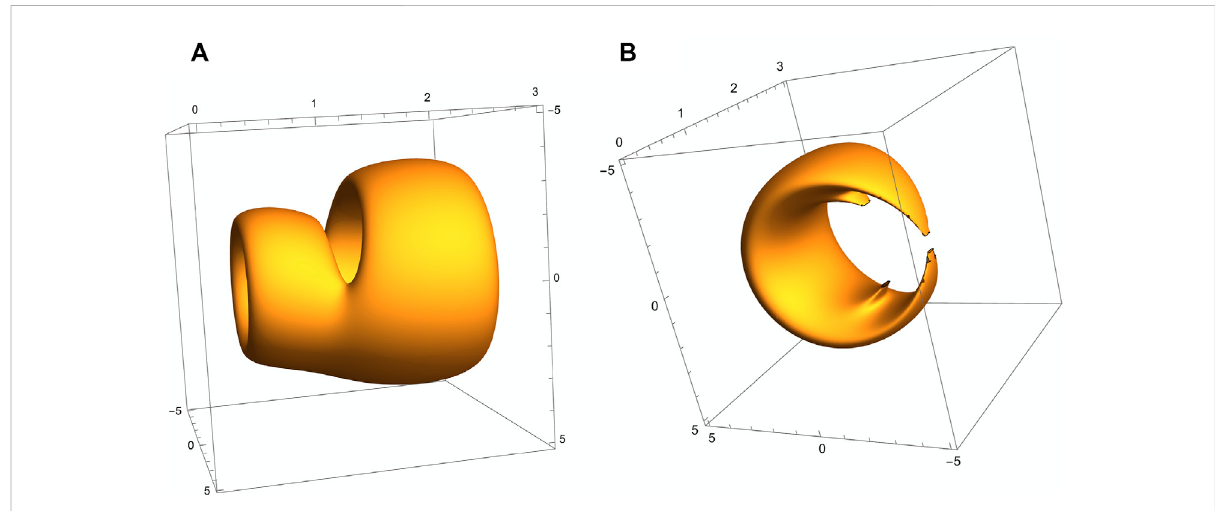
FIGURE 2 Modesuperpositionforself-torquepulseswithlargeamplitudedifferences,( a 1 / a 2 =10)forsmallquantumnumbers( ℓ 1 =1, ℓ 2 =2),for (A) -large time difference ( η 1 − η 2 = 3); (B) - for complete superposition ( η 1 = η 2